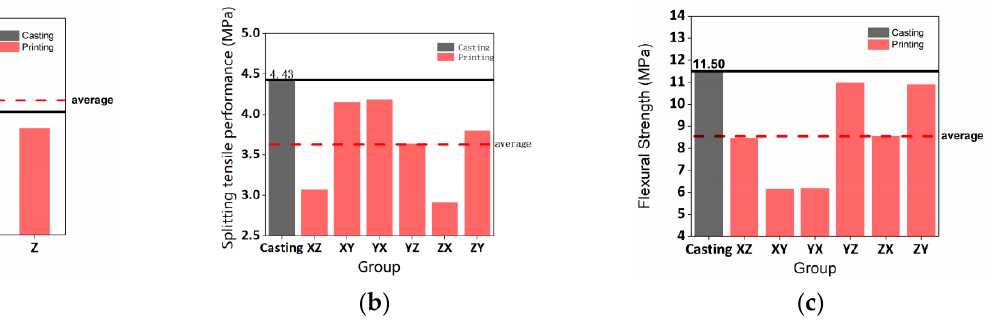
Figure 12. The mechanical performance average comparison of cast and printed samples in the varying directions: ( a ) compressive performance, ( b ) splitting tensile performance, ( c ) flexural performance.